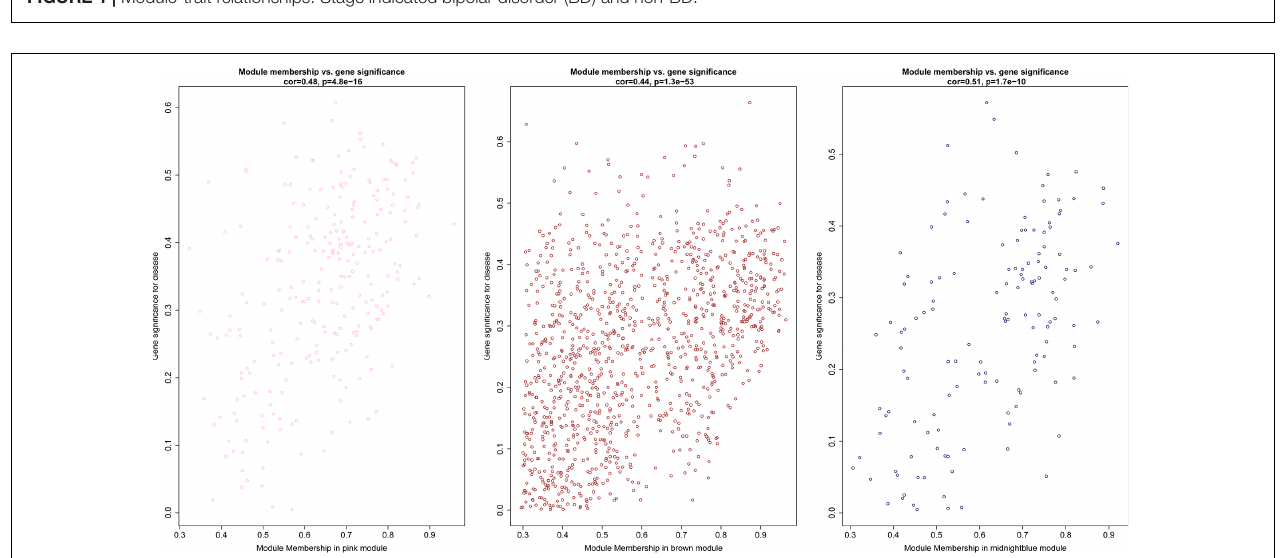
FIGURE 1 | Module-trait relationships. Stage indicated bipolar disorder (BD) and non-BD.